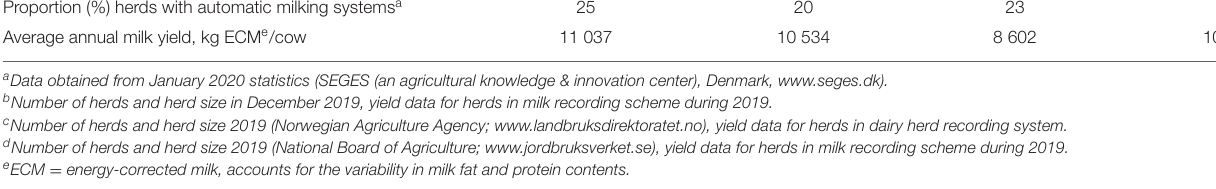
TABLE 1 | Descriptive statistics of milk production of dairy cows in four Nordic countries. Dairy herds,